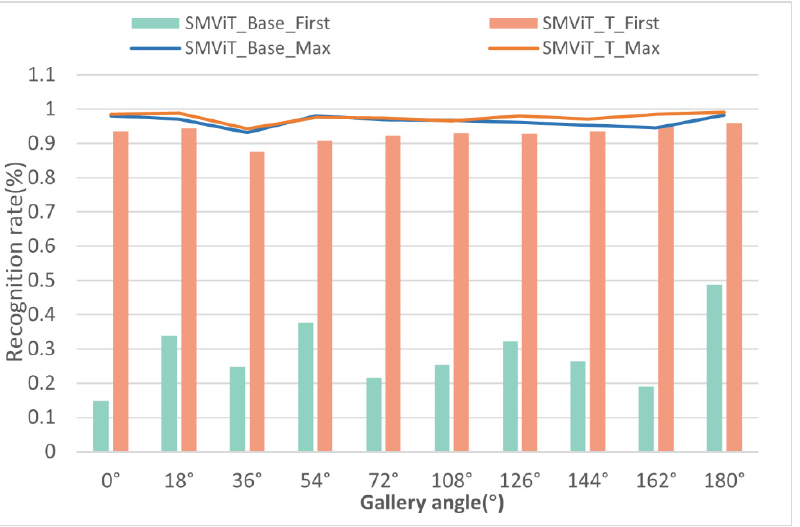
Figure 10. Comparison of the initial validation rate and the maximum validation rate of the pro ‐ posed model trained with or without gradually moving ‐ view training. model trained with or without gradually moving-view